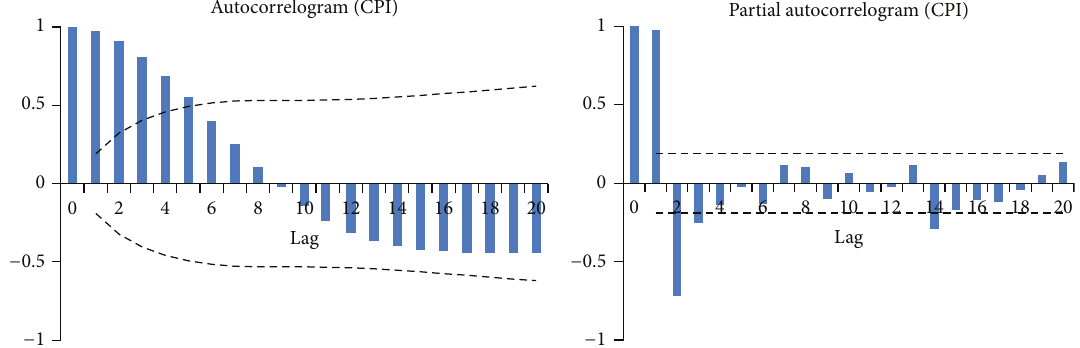
Figure 5: The autocorrelogram and partial autocorrelogram of CPI after descriptive analysis.